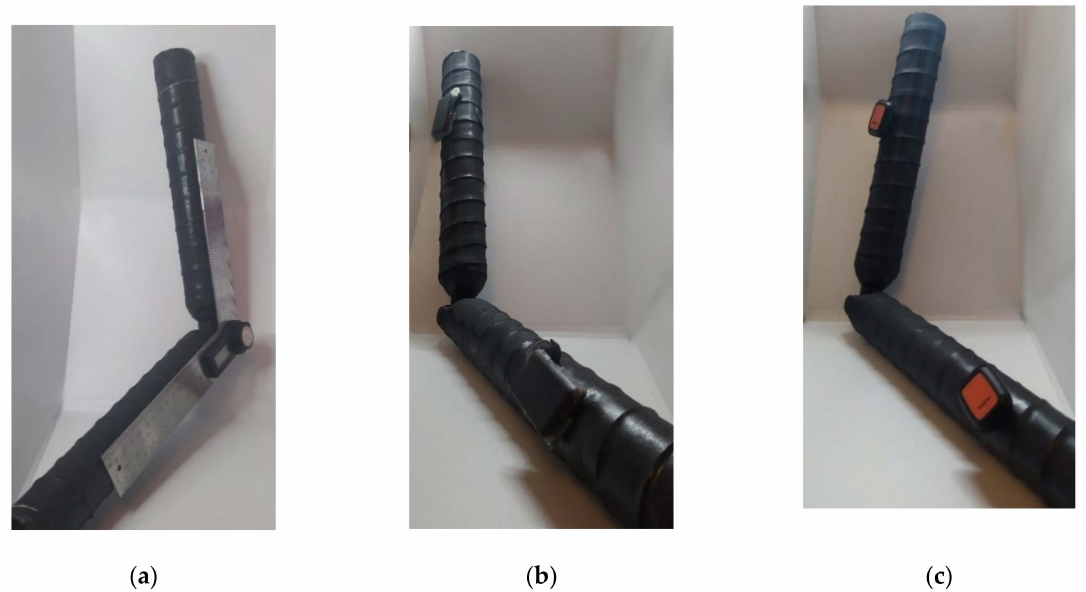
Figure 7. Artificial elbow joint using two cylindrical bars and a mechanic ball joint: ( a ) View of the digital goniometer from the right-side; ( b ) Custom Wearable (CW) sensors attached; ( c ) Xsens DOT (XDOT) sensors